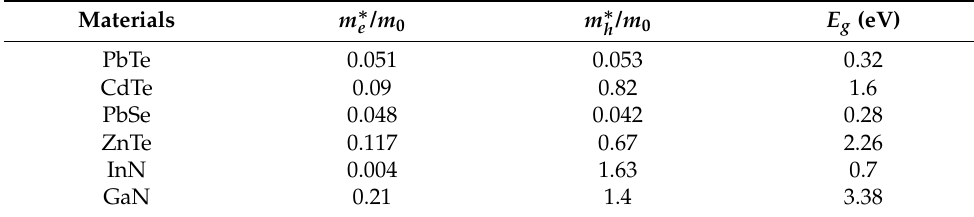
Table 1. Physical parameters of the different material systems using in the present calculations.